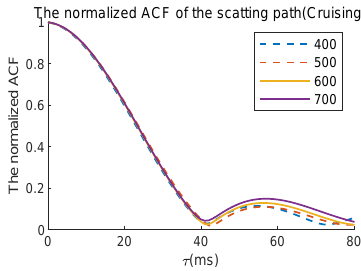
Figure 6. The normalized ACFs of the scattering path (Rising).